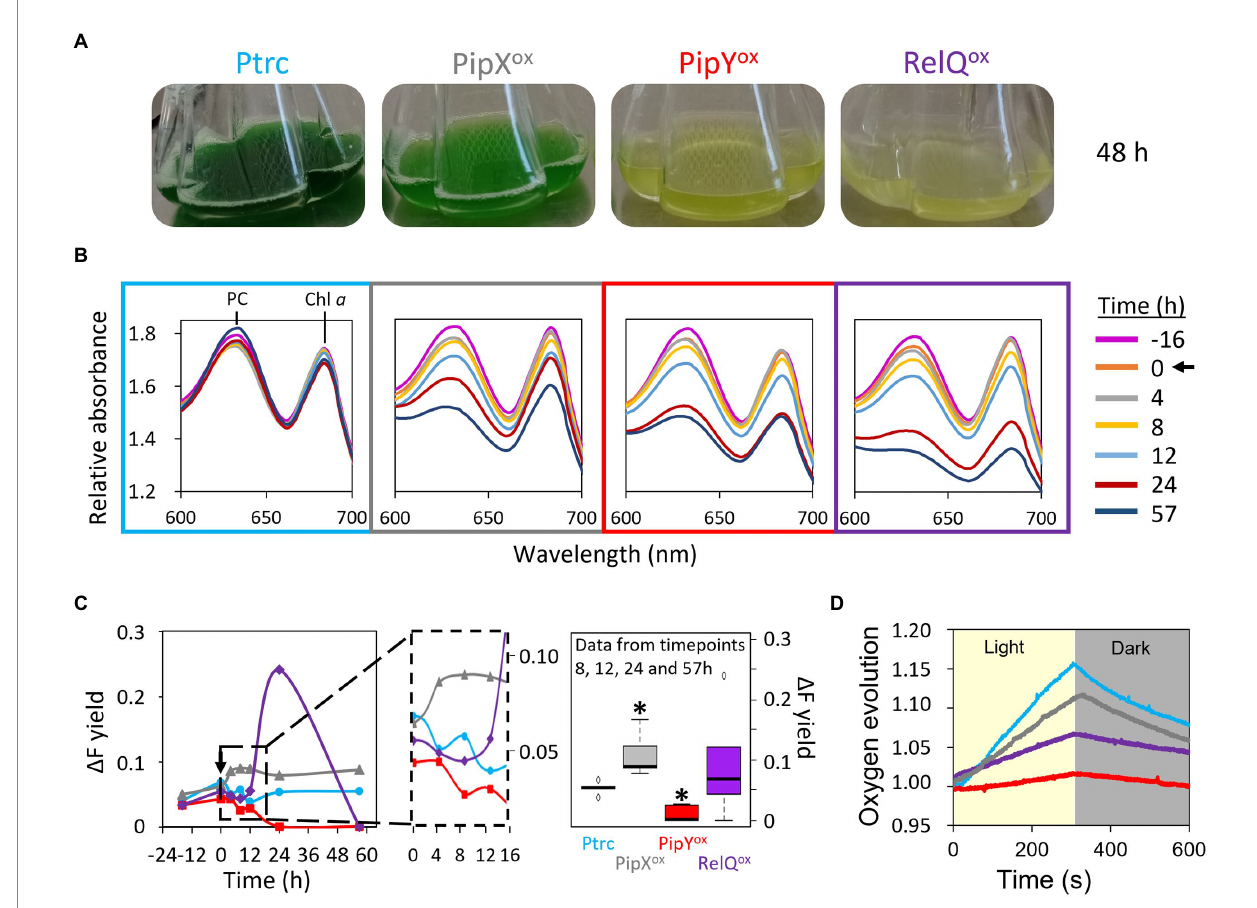
FIGURE 3 Distinctive features of chlorosis induced by PipX ox , PipY ox , or RelQ ox . (A) Visual appearance of cultures 48 h after IPTG addition. (B) Whole absorbance spectra of cultures treated with IPTG for the indicated times. Phycocyanin (PC) and chlorophyll a (Chl a ) peaks are indicated. Data representative from one out of three independent experiments. (C) (left) Apparent PSII quantum yield ( Δ F yield) measured by PAM fluorometry (one out of two representative experiments) and (right) boxplots of data from the timepoints 8, 12, 24, and 57 h. The box of two independent experiments contains 50% of the values, with median indicated as a horizontal line and dots representing the outliers. Wilcoxon rank sum test analysis of data between Ptrc and overexpression strains produced p -values <0.01 ( * ). (D) Oxygen evolution during a 300/300 s light/dark exposure of strains treated with IPTG for 24 h. In (B,C) black arrows indicate the exact timepoint of IPTG addition, and the inset corresponds to zoom of the indicated region. Labels, data points, and panel outlines are colored to indicate the strains as follows: Ptrc-light blue, PipX ox -gray, PipY ox -red, RelQ ox -purple. Other details as in Figure